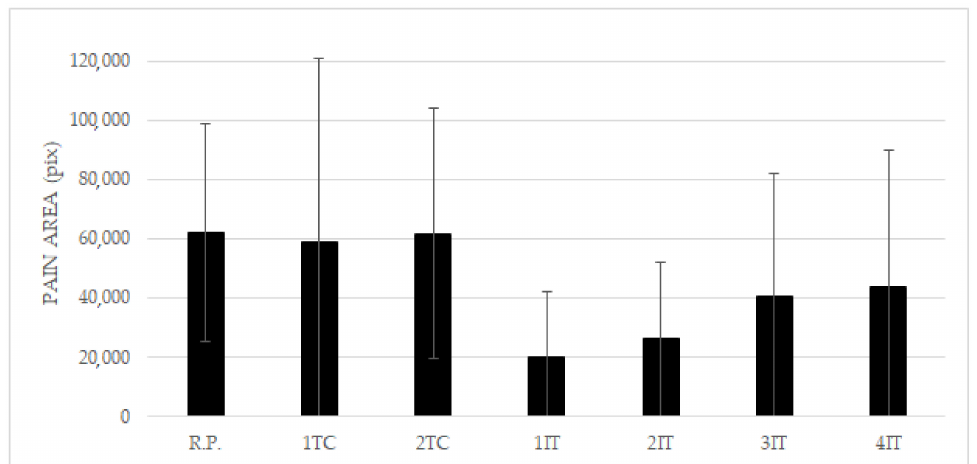
Figure 5. The average total pain area (sum of the areas from the front and back views of the body scheme) of an amputee football field player during training camp and an international tournament. R.P.—a recall of typical pain after a match. Maximal possible value is 396,630